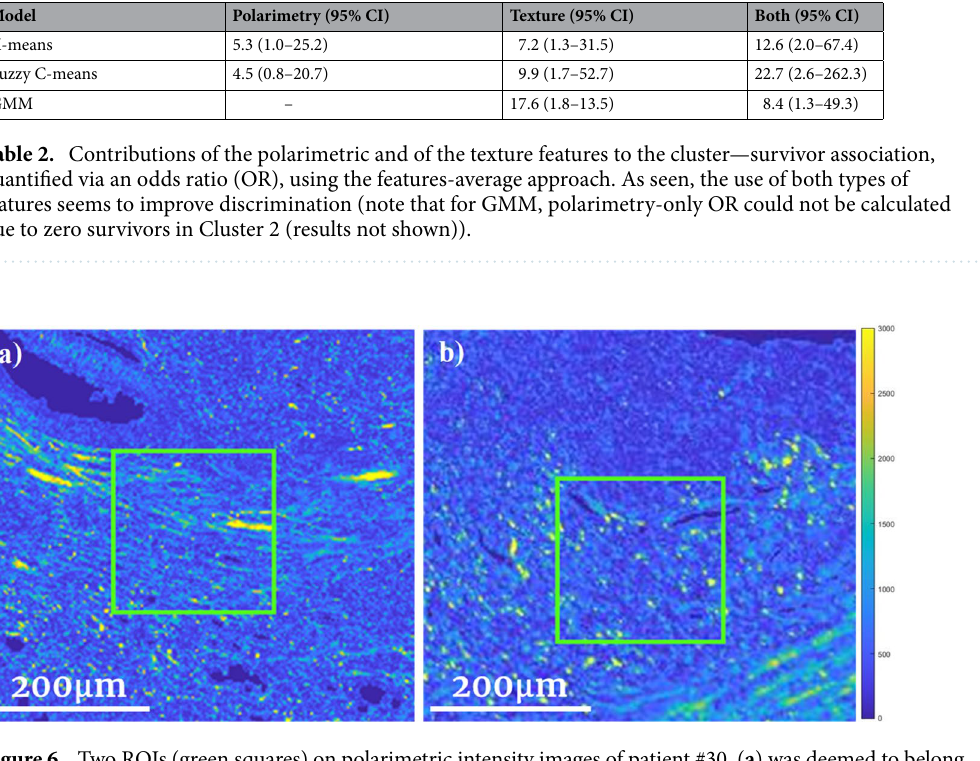
Figure 6. Two ROIs (green squares) on polarimetric intensity images of patient #30. ( a ) was deemed to belong to Cluster 1 with a weight of 90%, in comparison to ( b ) which was also considered to belong to Cluster 1, but with a weight of 56% (Fuzzy C-means algorithm). There are visible structural differences as is indeed reflected in the derived weights; this relative weight information could be used in future model